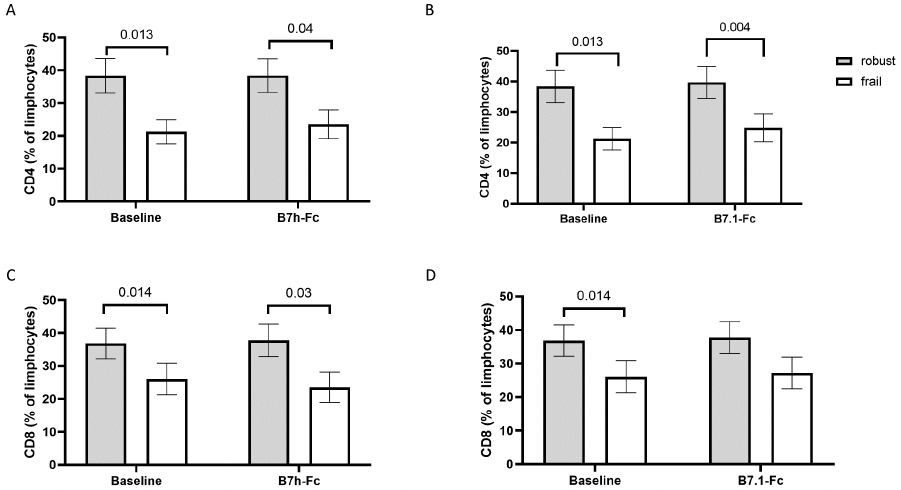
Cells 2023 , 12 , x FOR PEER REVIEW 6 of 12